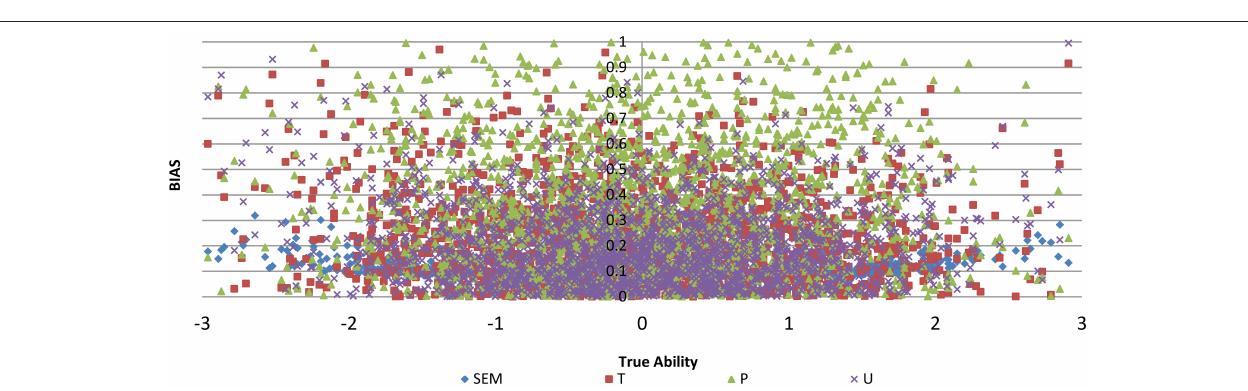
FIGURE 4 | BIAS against true ability for three item selection methods T, P, and U, with no item exposure control for test length of 30 for method